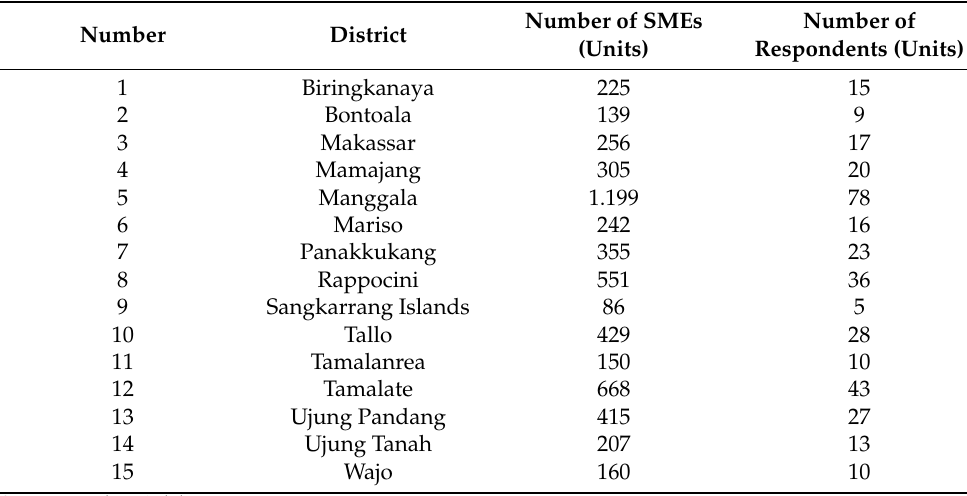
Table 2. Numbers of small and medium enterprises (SMEs) based on shariah economy by district in